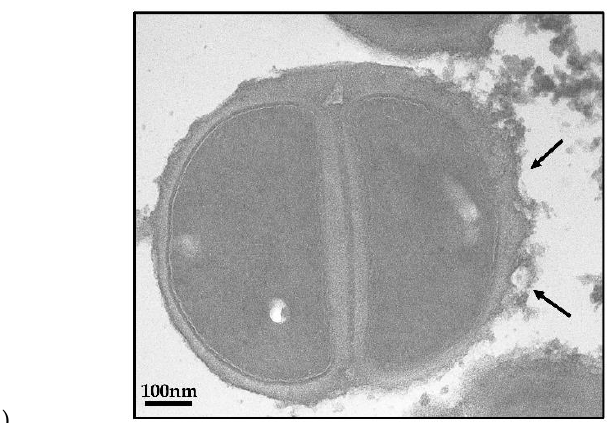
Figure 4. TEM micrographs of MRSA incubated at the following conditions: ( a ) control; ( b ) 40 µ g / mL TGII for 10 min; and ( c ) control, ( d ) 40 µ g / mL TGII for 24 h. The arrows in Figure 4b,d indicate cell wall alteration in MRSA cells. Untreated MRSA cells served as the control group in the TEM imaging observation.